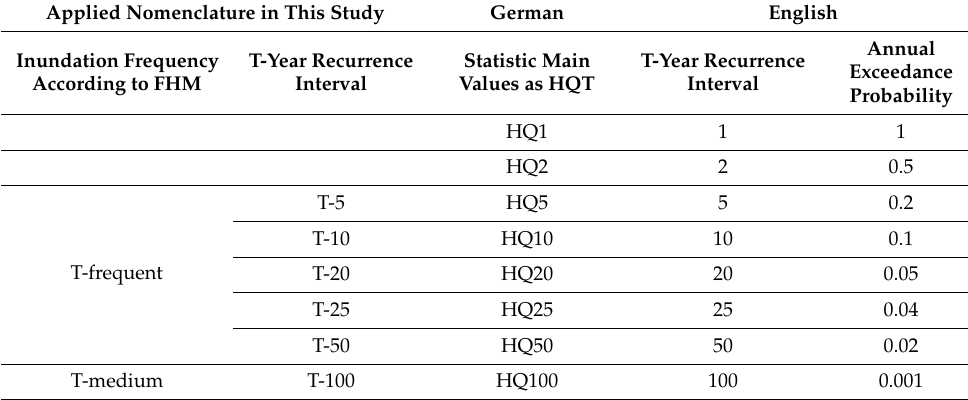
Table 1. German and English abbreviations of calculated recurrence intervals for selected floods. The English abbreviations were obtained from [12]. The terminology applied in this study and its connection to flood hazard maps (FHM) and recurrence intervals is shown. German English T-Year Recurrence T-Year Recurrence Interval